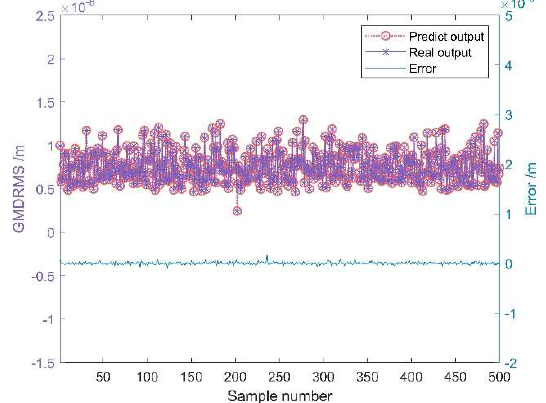
Figure 10. The comparison of the results of the GMDRMS training set. Table 2. Evaluation of the predictive effect of